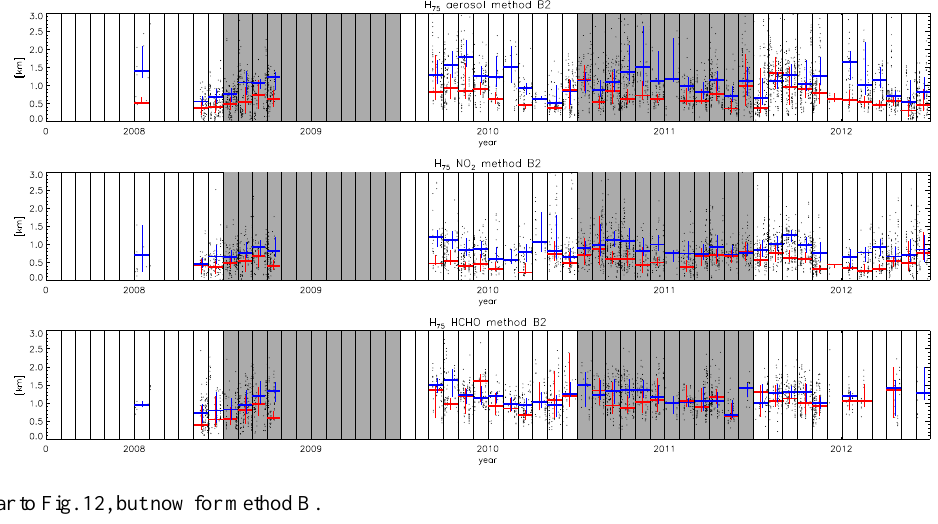
Figure 13. Similar to Fig. 12, but now for method B.